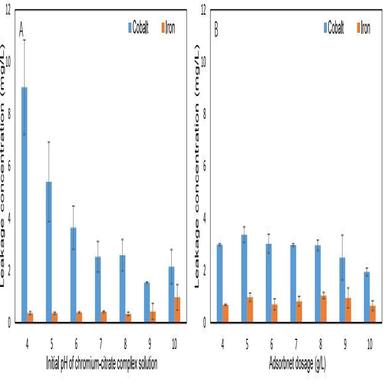
Effects of (A) pH value and (B) adsorbent dosage on the leaching of cobalt and iron.